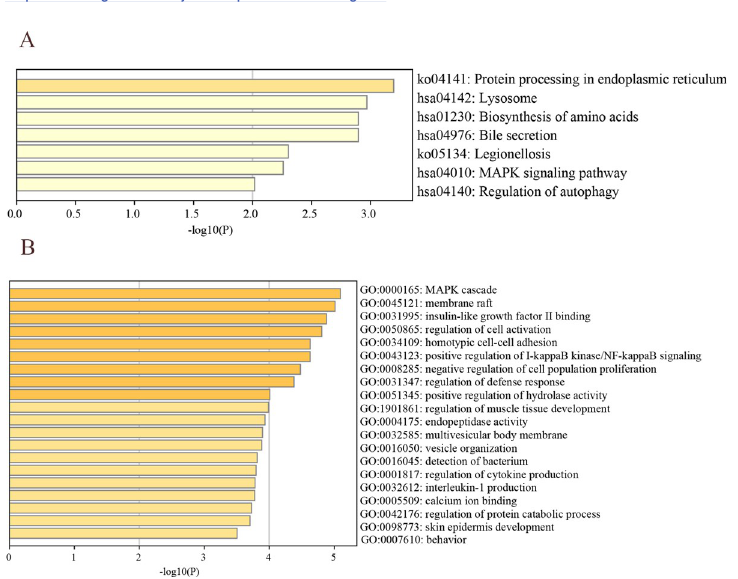
Fig 7. Functional analysis of differential genes among m 6 A cluster. (A) GO functional analysis of core genes. (B) KEGG functional analysis of core genes. https://doi.org/10.1371/journal.pone.0264384.g007 PLOS ONE | https://doi.org/10.1371/journal.pone.0264384 February 23,